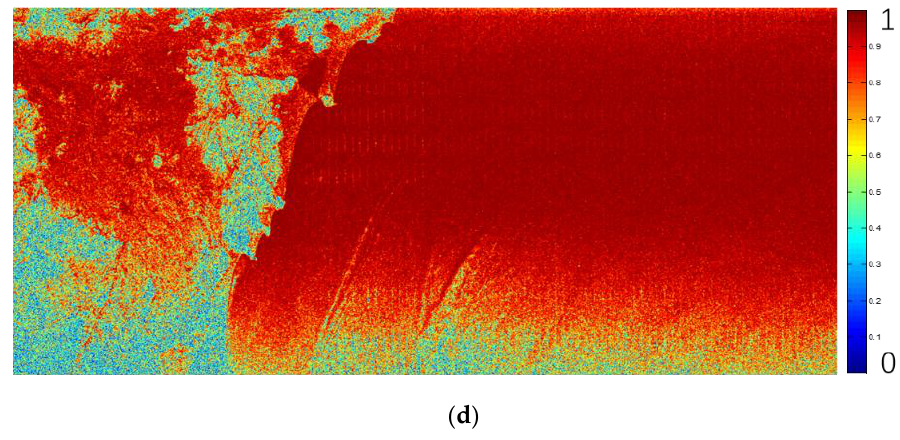
Figure 7. ( a ) Intensity image in slant-range direction without antenna pattern correction; ( b ) coregistered phase of two SAR complex images; ( c ) relative phase after flat-earth phase removal; ( d ) coherence between two SAR complex images. The azimuth and slant-range directions are indicated by arrows.